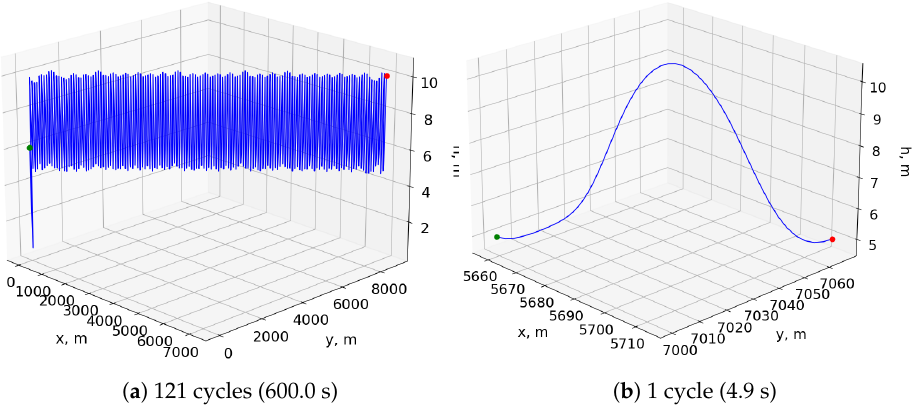
Figure 8. Simulated trajectories of the dynamic soaring albatross neurocontroller, with start marker (green), end marker (red), and path